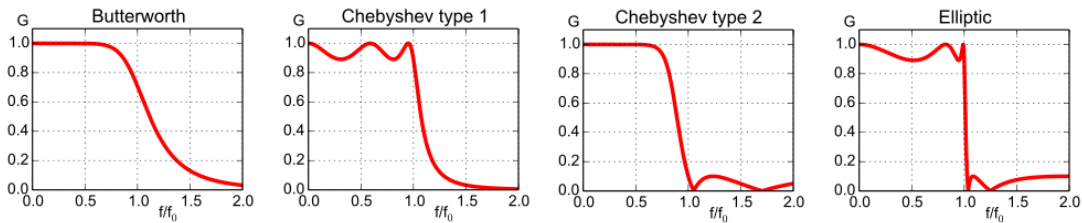
Figure 2. The discrete - time gain with Butterworth, Chebyshev, and Elliptic filters [8] .